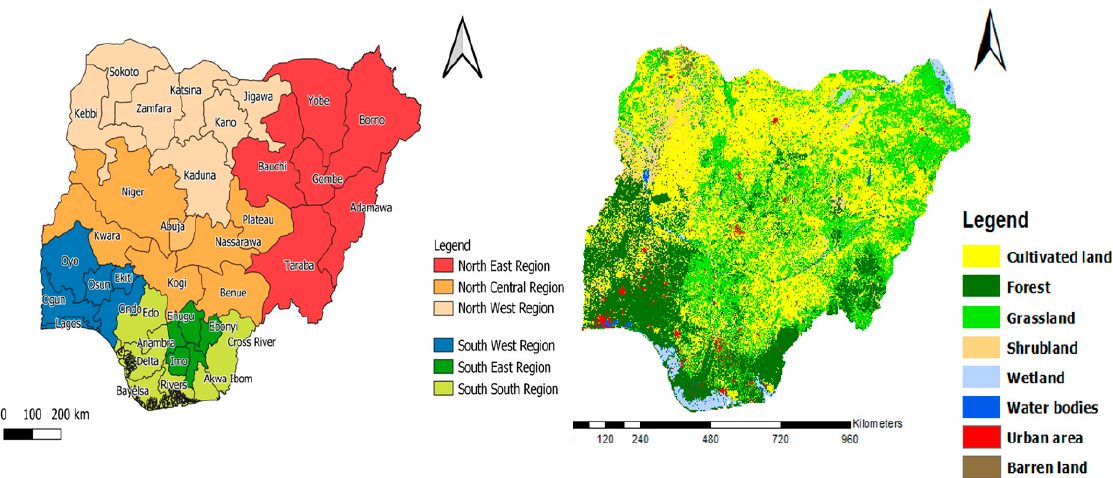
Figure 1. Location and land use land cover map of the six geopolitical zones in Nigeria. Table 1. The six geopolitical zones’ information at a glance.